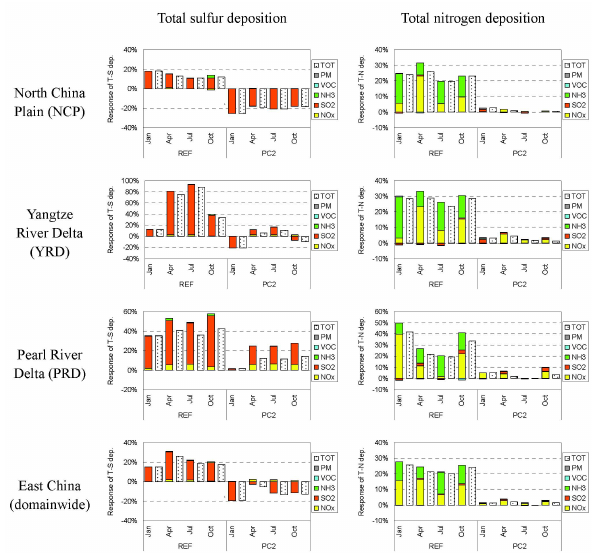
Fig. 9. Percentage changes of total S/N-deposition relative to the 2005 scenarios in 2020 (monthly total; TOT represent the differ- ences between two future scenario with 2005 baseline, PM, VOC, NH 3 , SO 2 , NO x represent the individual impacts of their emission changes in